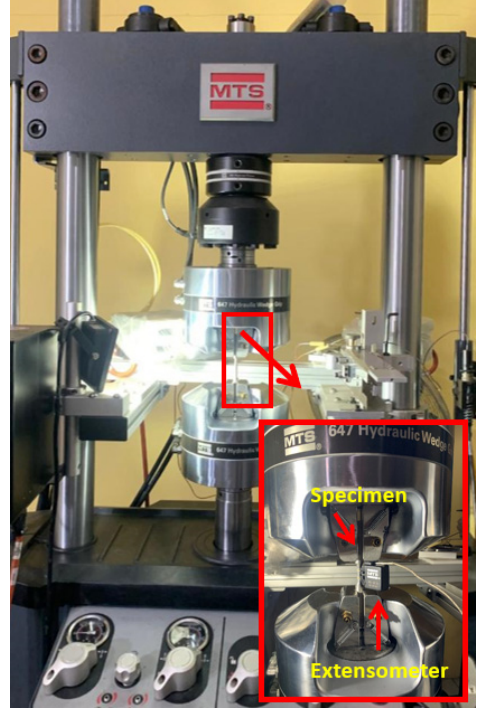
Figure 2. Detailed view of the experimental setup and mounting extensometer on the